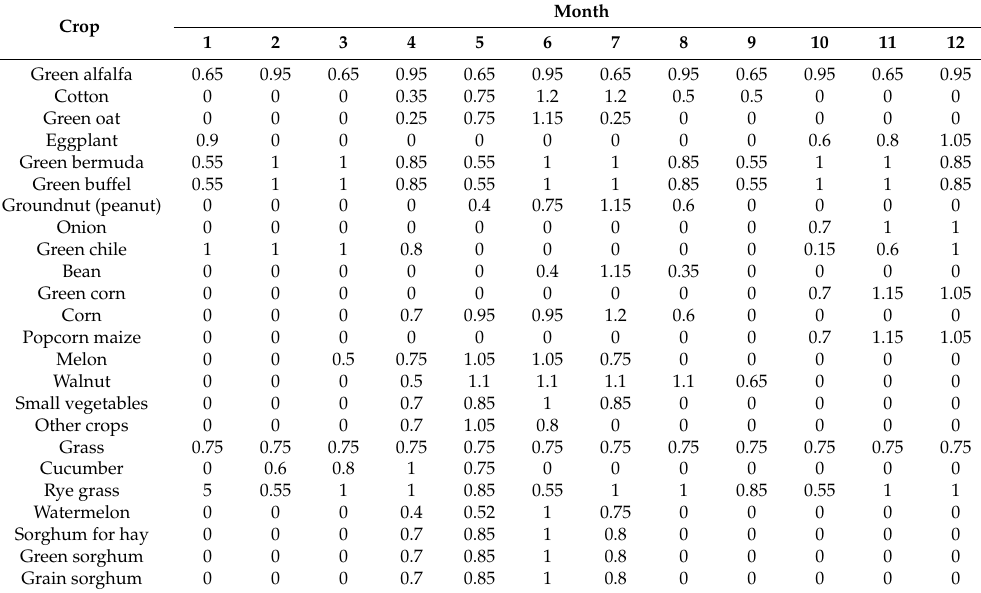
Table A2. Average values of Kc per crop in the IDs of the Rio Bravo Basin